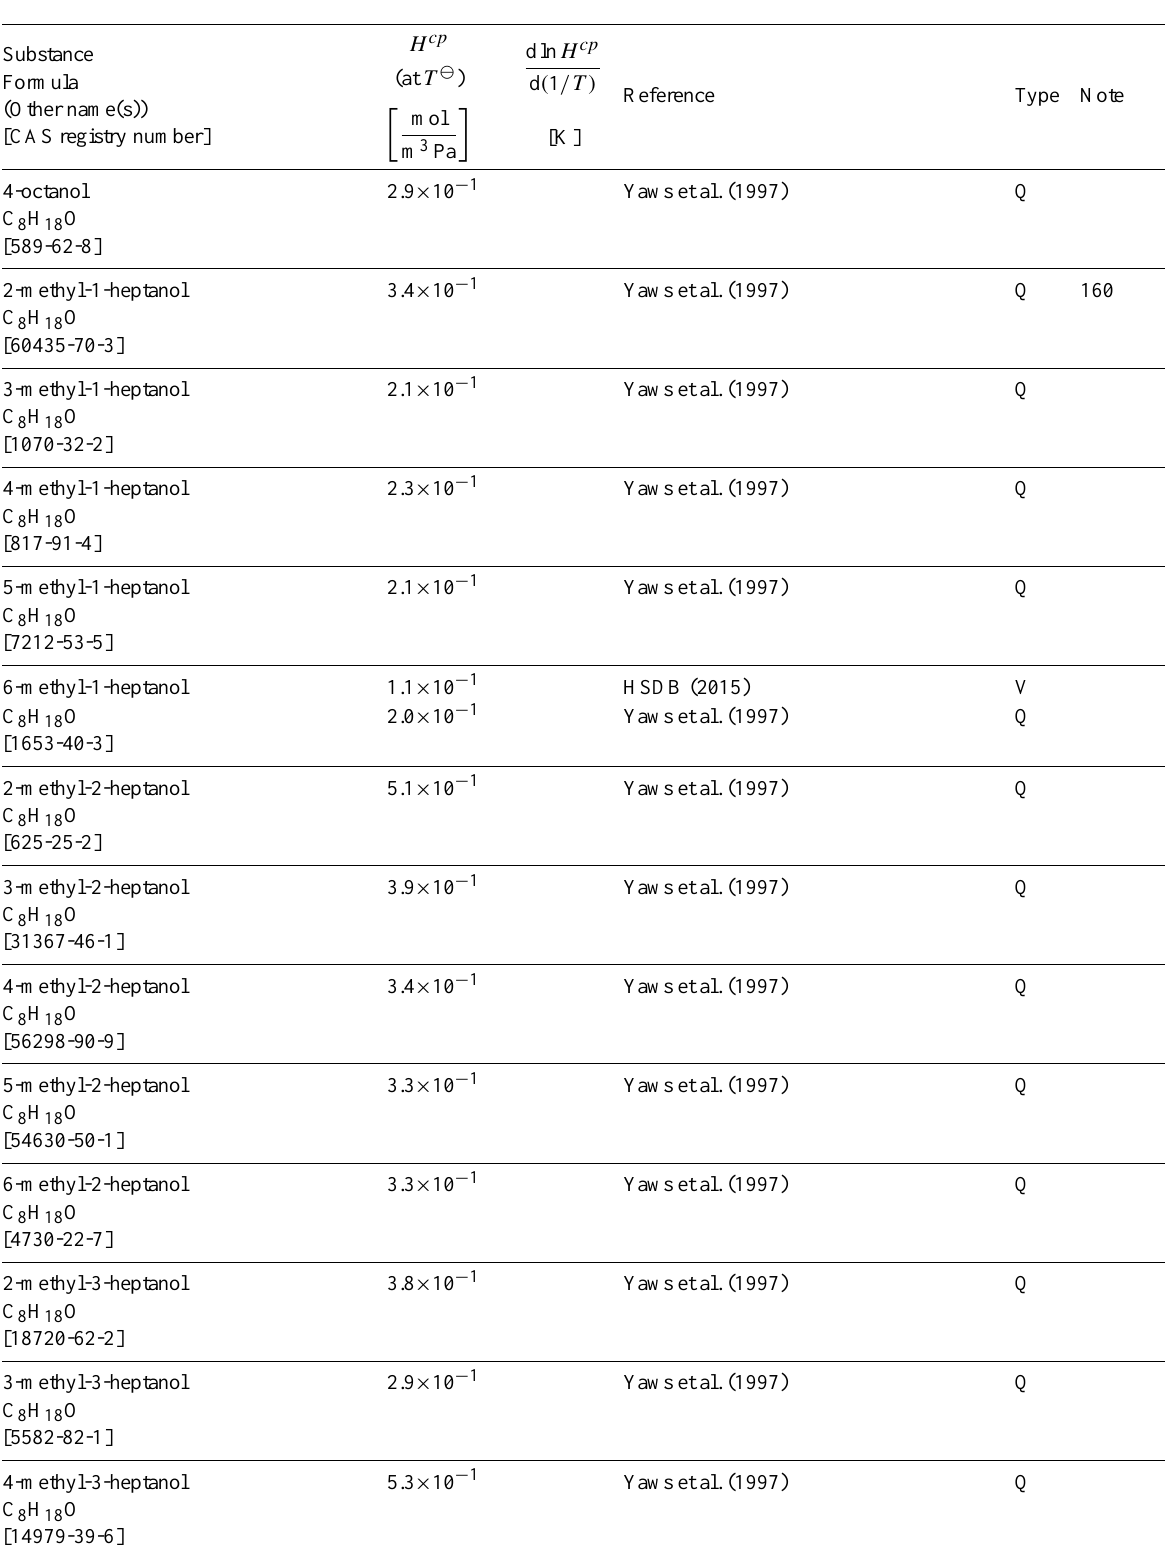
Table 6: Henry’s law constants for water as solvent